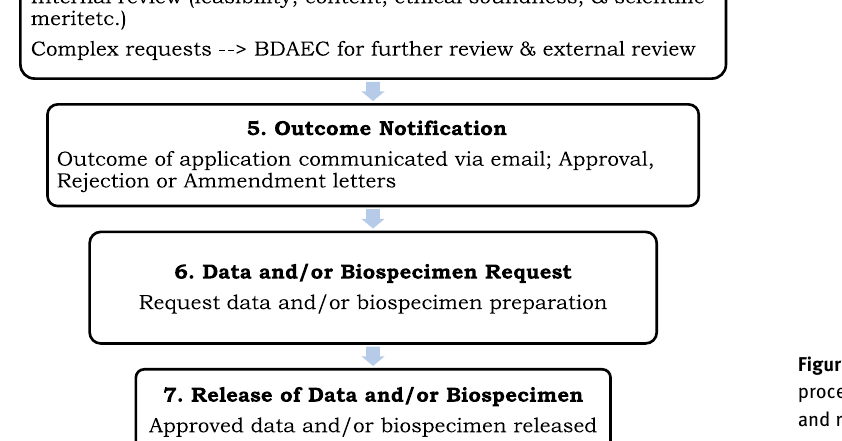
Figure 3: Flowchart for the application process for access to biospecimens, data and resources of the NHLS for research